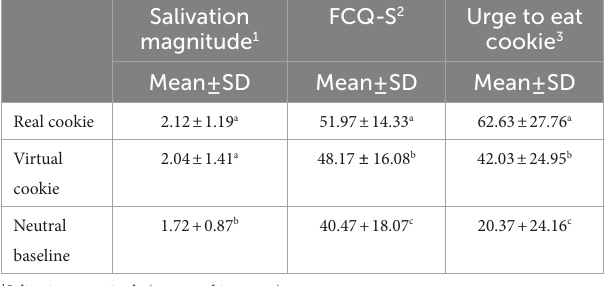
TABLE 1 Means and standard deviations (SD) of food craving measures for comparisons between VR and real-world exposure